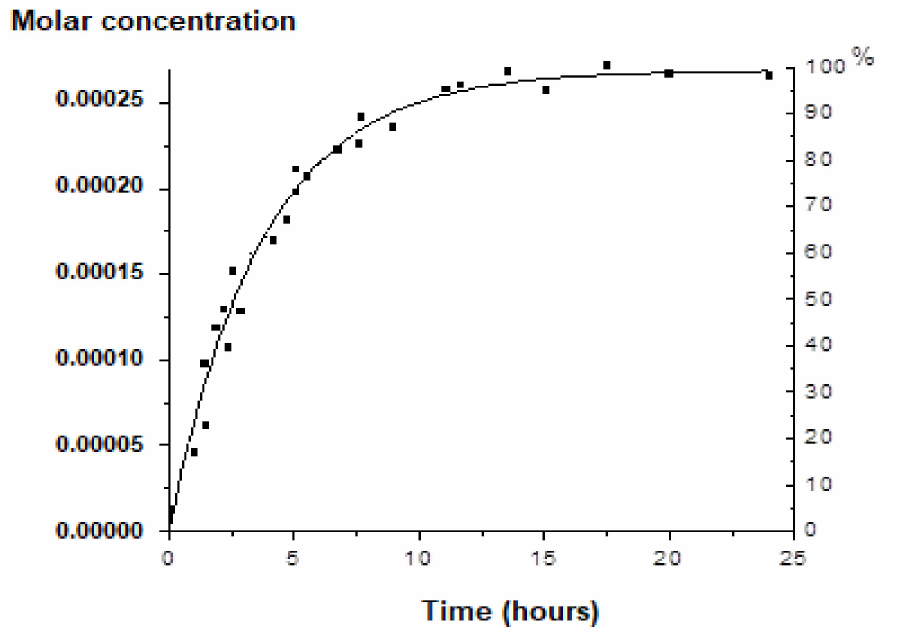
Figure 4. The in vitro release of zinc (molar concentration) from LVC-Zn. Values are expressed as mean ±